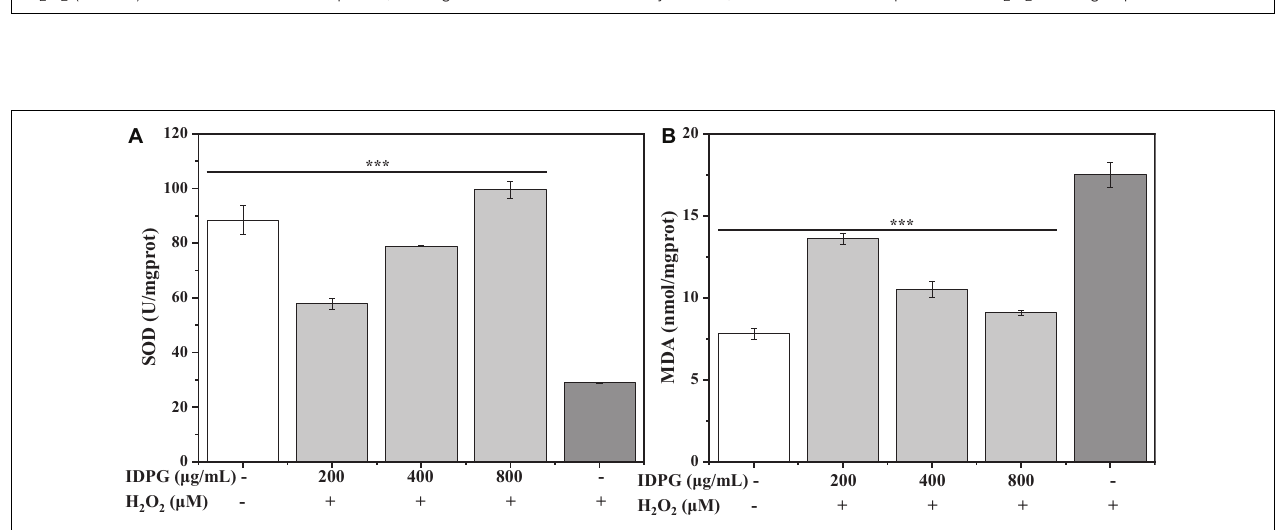
FIGURE 1 | (A) Effects of incomplete degradation products of galactomannan (IDPG) on the cell viability of RAW264.7 cells. The RAW264.7 cells were treated with IDPG for 24 h; All data were in triplicate, and significance was determined by ANOVA; * P < 0.05, ** P < 0.01, *** P < 0.001 as compared to the untreated control. (B) Effect of H 2 O 2 on cell viability. Cells were treated with H 2 O 2 for 4 h; All data were in triplicate, and significance was determined by ANOVA; *** P < 0.001 as compared to the untreated control. (C) Protective effect of IDPG on the H 2 O 2 injured RAW 264.7 cells. Cells were treated with IDPG for 24 h before incubation with H 2 O 2 (2.4 mM) for 4 h. All data were in triplicate, and significance was determined by ANOVA; *** P < 0.001 as compared to the H 2 O 2 model group.